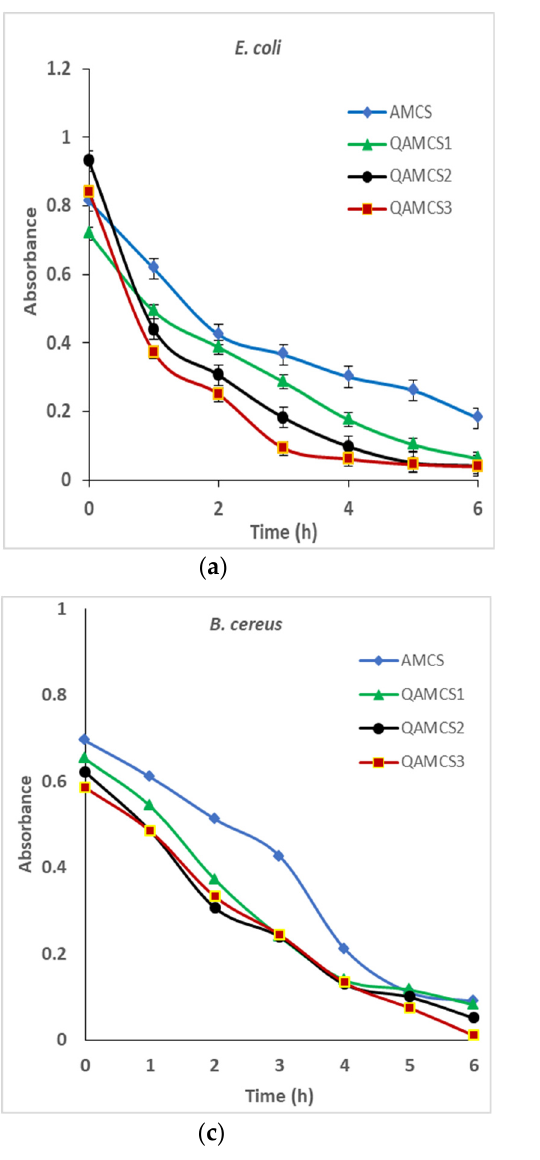
Figure 8. Bactericidal profiles of aminochitosan, quaternized aminochitosan 1, quaternized aminochitosan 2 and quaternized aminochitosan 3 membranes against ( a ) E. coli , ( b ) P. aeruginosa , ( c ) B. cereus and ( d ) S. aureus . All measurements were accomplished in triplicate ( n = 3), and data obtained are expressed as means and standard deviations (±SD).